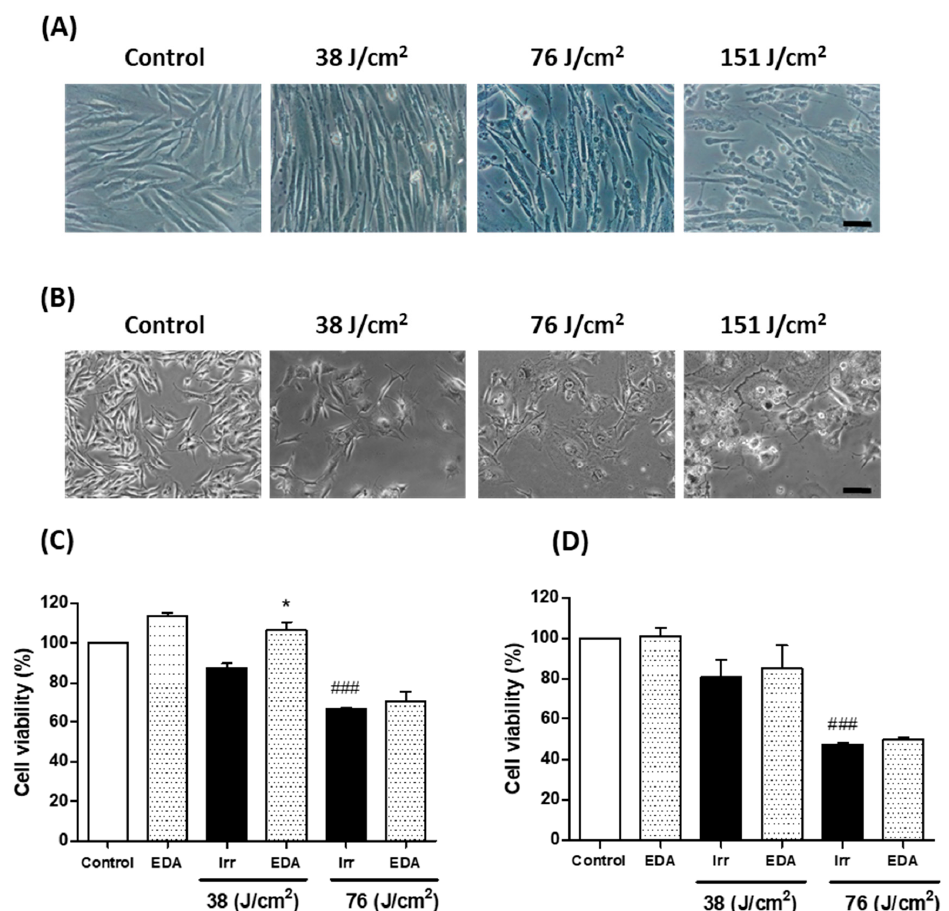
Figure 1. Cell viability changes induced in HDF ( A , C ) and melanocytes ( B , D ) exposed to artificial blue light and EDA pre-treatment. Cells were incubated with EDA 0.1 mg/mL for 24 h and then irradiated at the indicated doses. Cell viability was evaluated by MTT assay performed 24 h after irradiation ( n ≥ 3). Data were expressed as % of control cells. Data are shown as mean ± standard error of the mean (SEM). ### p < 0.001 vs control cells and * p < 0.05 vs the corresponding irradiated (Irr) cells. Scale bar: 50 µm.